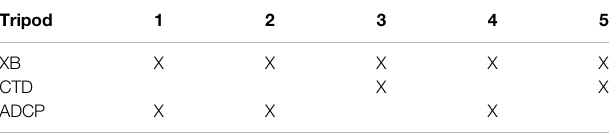
TABLE 1 | Sensors deployed on each tripod. See Figure 1 for placement locations.